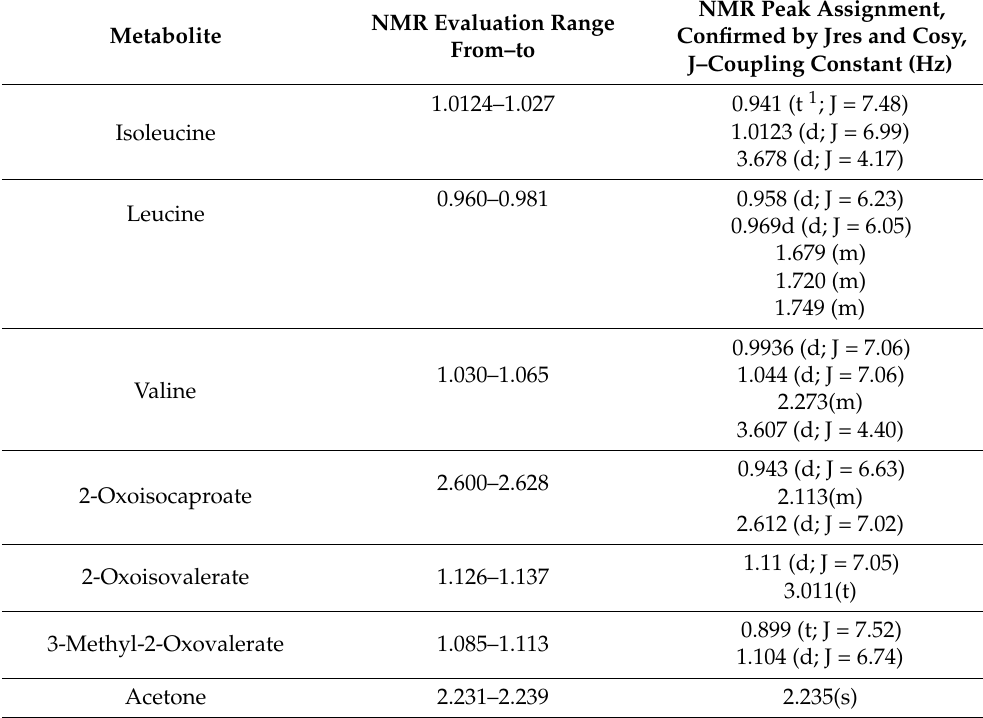
Table 2. Chemical shifts (in ppm), J couplings (in Hz), and multiplicities for the pool of metabolites identified in cell culture medium by NMR. The 1 H-NMR chemical shifts are reported relative to TMSP-D 4 signal, to which the value of chemical shift equal to 0.000 ppm was assigned.